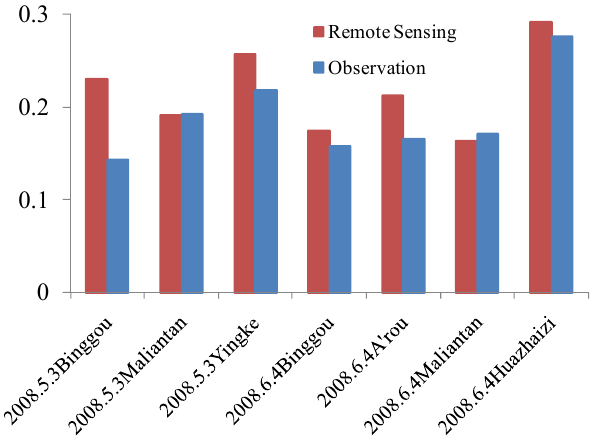
Fig. 7. Validation of the derived albedo against ground measure- Fig. 7 Validation of the derived albedo against ground measurements over the WATER stations. ments over the WATER stations.